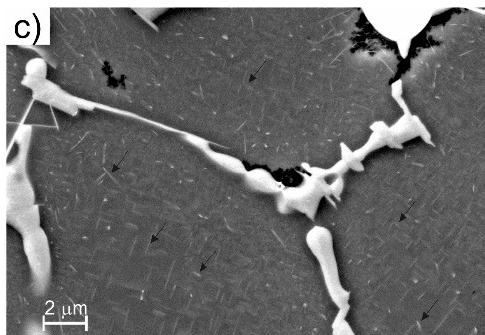
Figure 5. Content of Al and Cu in the α -Al matrix from EDS analysis as a function of homogenisation time analyzed with EDS ( a ) and SEM image of particles/precipitates formed after homogenisation annealing at 310 °C ( b ) and 520 °C ( c ) in the investigated EN AW 2011 aluminium alloy. Black arrows are marking equilibrium θ precipitates and red arrows are marking transition precipitates θ ’ and θ ’’.